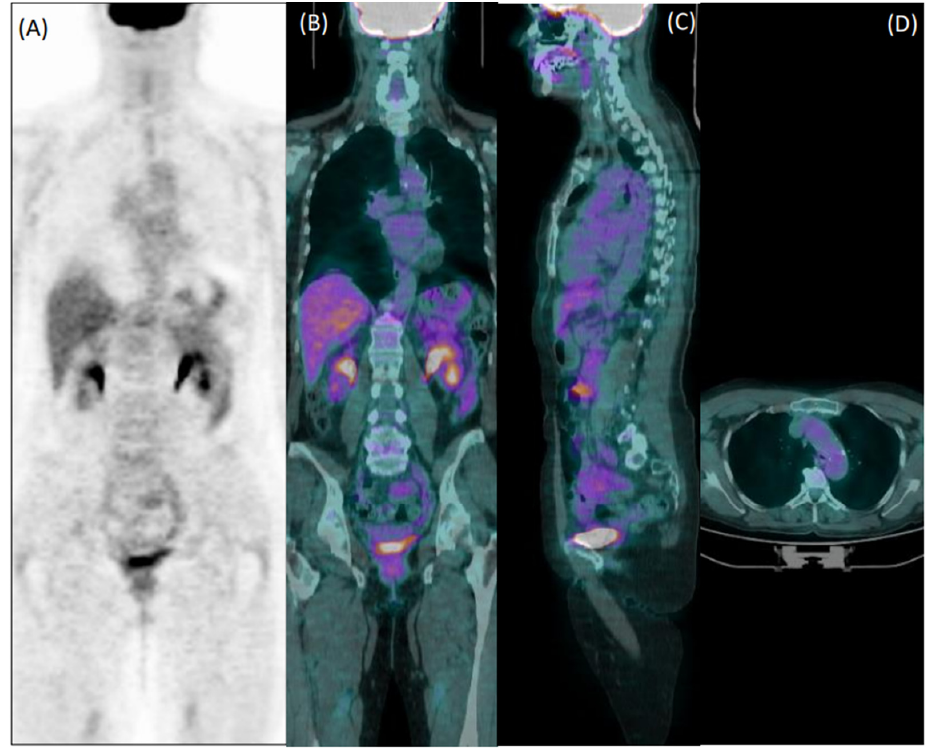
Figure 3. Coronal [ 18 F]FDG PET ( A ) and fused PET/CT coronal ( B ), sagittal ( C ), and axial ( D ) images of a 60-year-old female patient with giant cell arteritis, who performed the exam in the course of corticosteroid therapy. Both readers evaluated images as negative for arteritis.